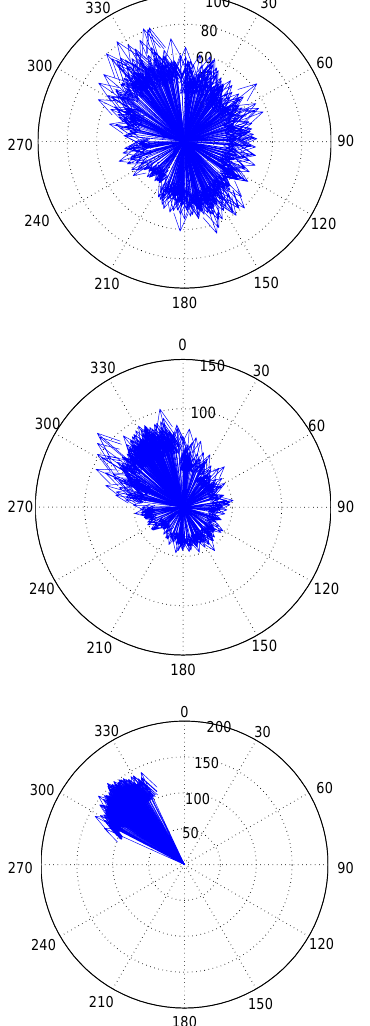
Fig. 8. Division of speed (given by the sum of surge and mean resid- ual flow incms − 1 ) into twelve 30 ◦ directional sectors, at depths 349, 499 and 649 m from top to bottom.